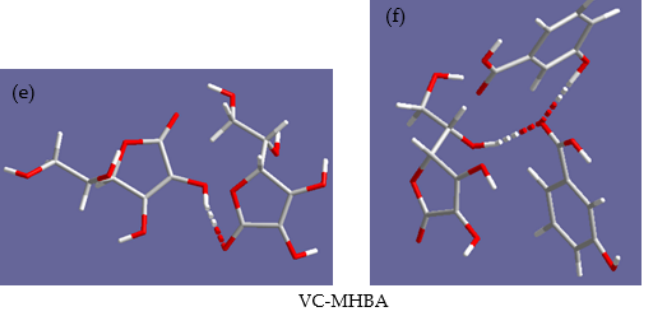
Figure 2. ( a ): VC-NA, ( b ): VC-DHB, ( c , d ): VC-PCA, ( e , f ): VC-MHBA. Probable interactions between VC and CCFs. All the molecules are represented with wires and sticks; C, H, O and N are represented by gray, white, red and blue, respectively.